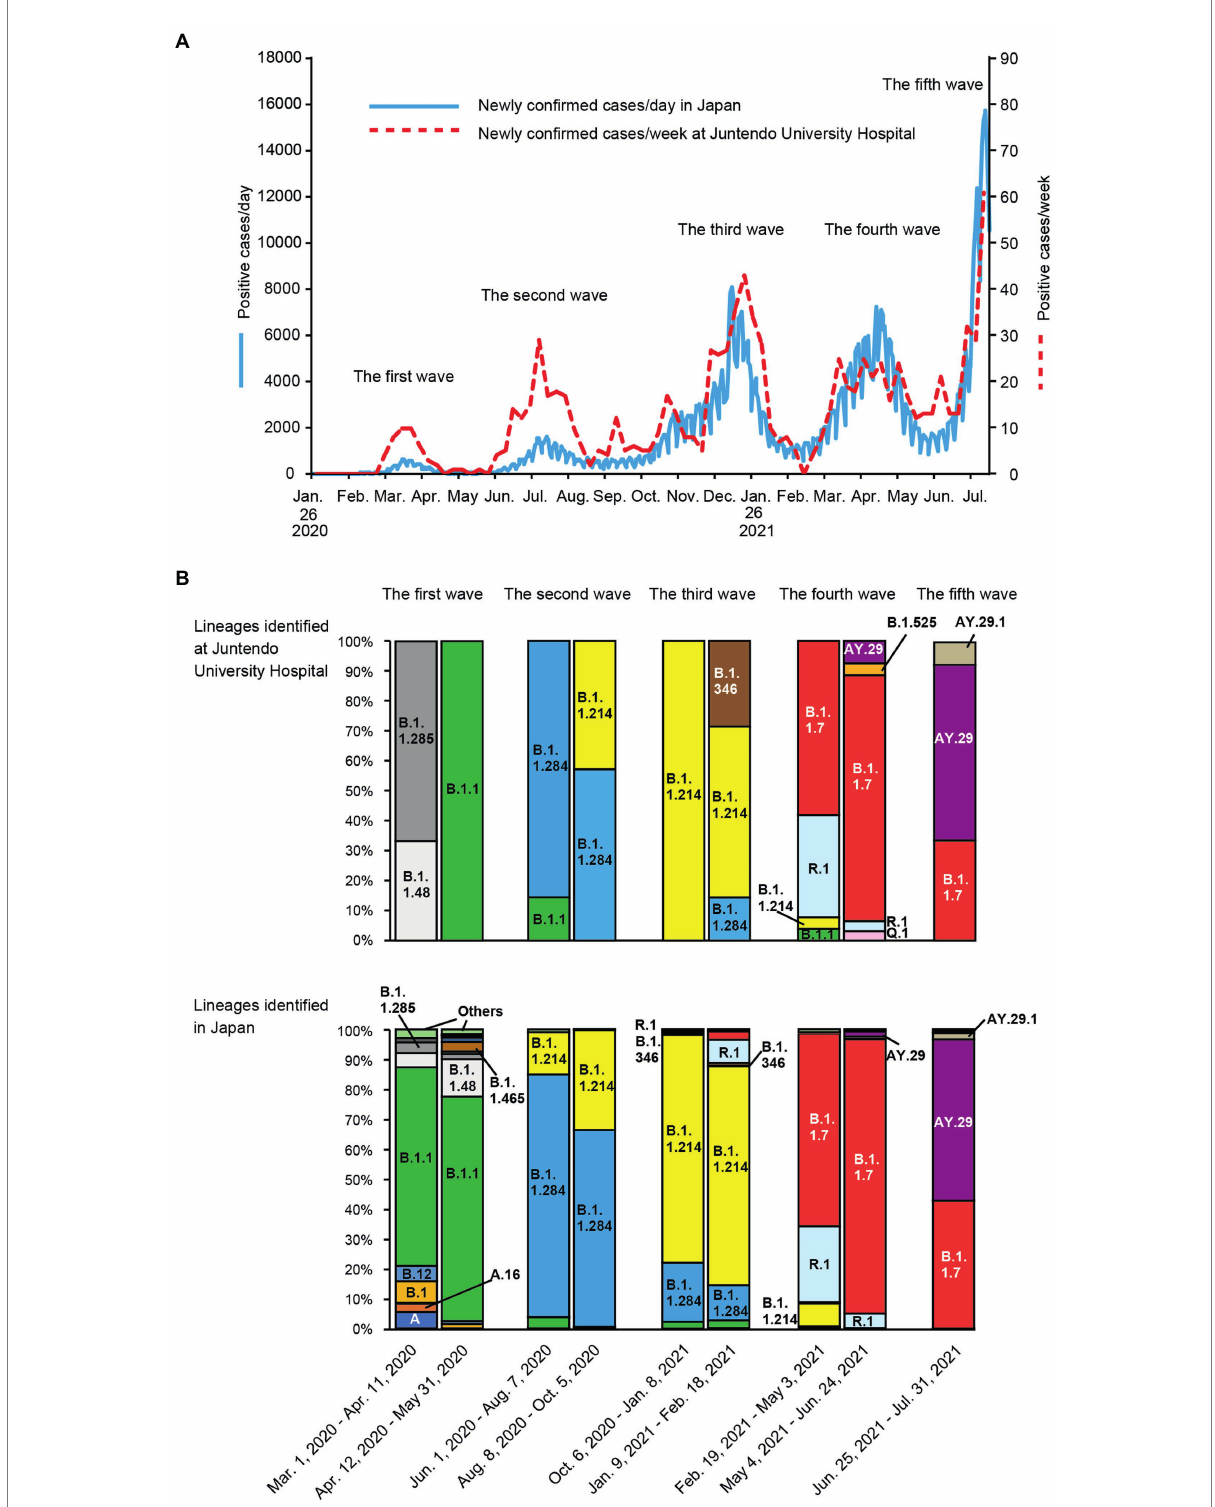
FIGURE 1 Trend of SARS-CoV-2 positive cases and lineage analysis of the viruses in each wave. (A) the numbers of newly confirmed cases per week in Japan and newly confirmed cases per day at Juntendo University Hospital are shown by the blue solid line and the red dotted line, respectively. (B) the ratios of the identified lineages at Juntendo University Hospital and in entire Japan during the designated periods are